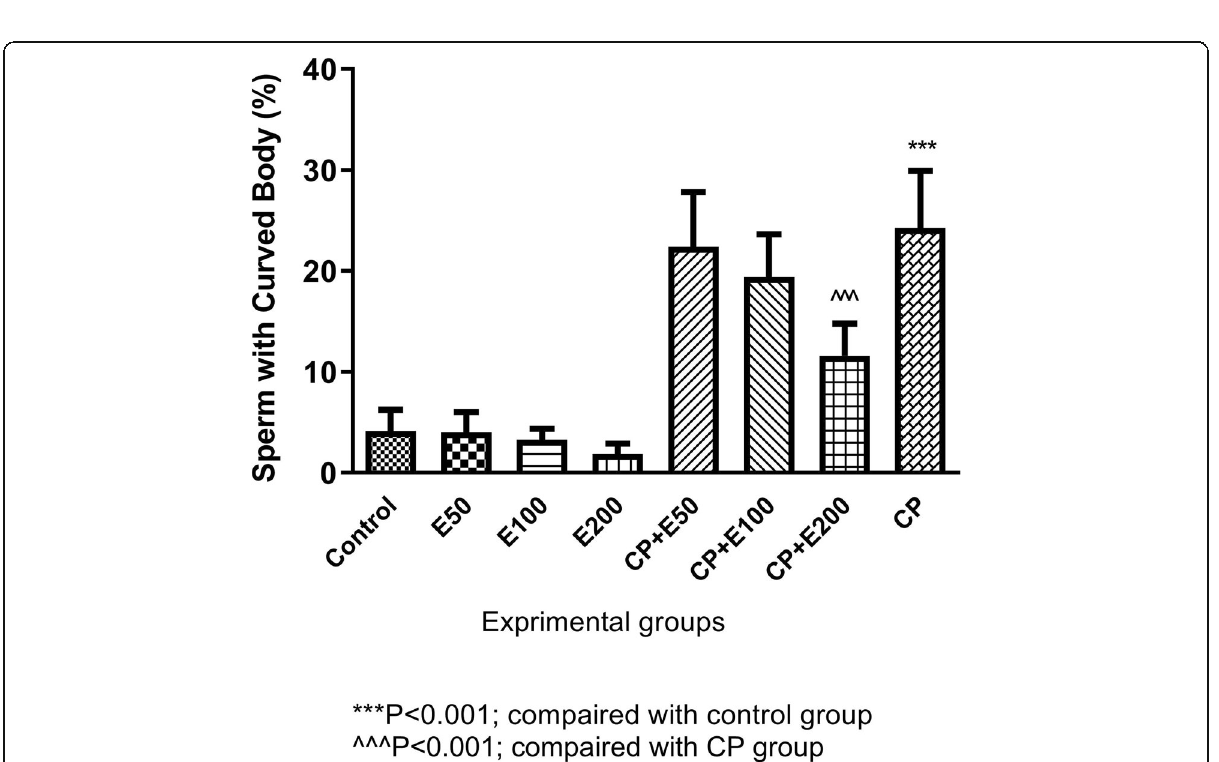
Fig. 9 The effect of Allium atroviolaceum L. extract (E) on the number of the sperm with curved body in cyclophosphamide (CP)-treated